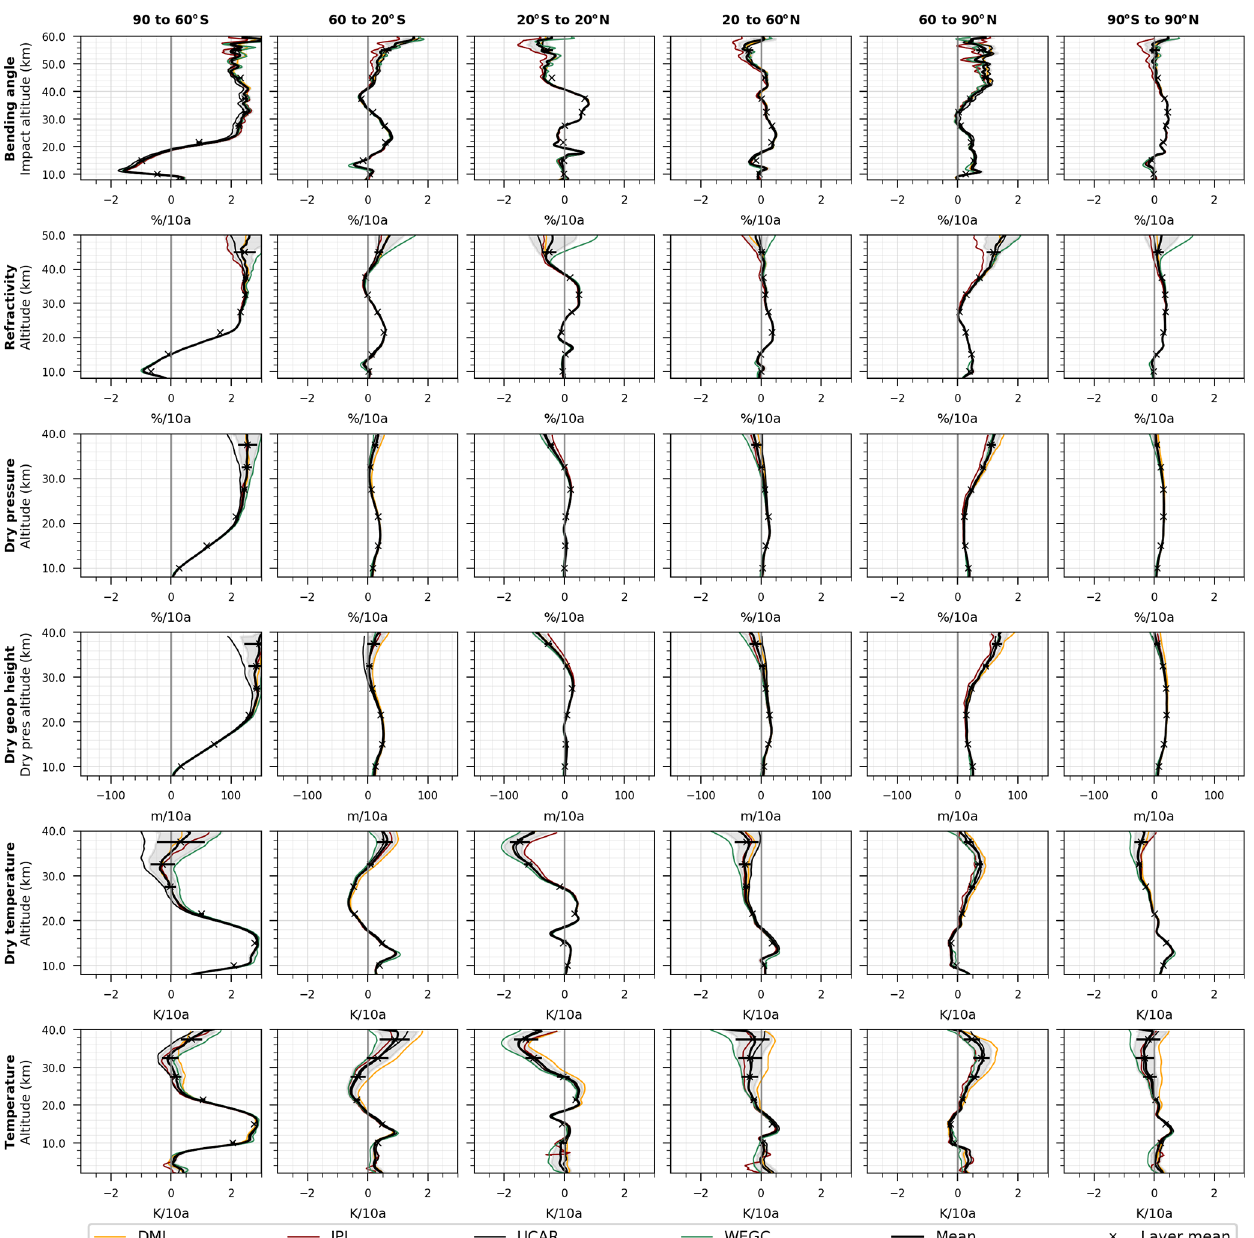
Figure 9. F3C structural uncertainty indicated as the standard deviation (gray) of the individual center trends per decade based on 10 ◦ zonal medians for DMI (orange), JPL (red), UCAR (black), and WEGC (green); shown for bending angle, refractivity, dry pressure, dry geopotential height, dry temperature, and temperature (top to bottom). The all-center mean trend profile (bold black line) and the altitude- layer mean trends (crosses, with horizontal bars showing the uncertainty) are indicated. Profiles are smoothed with a 1km running